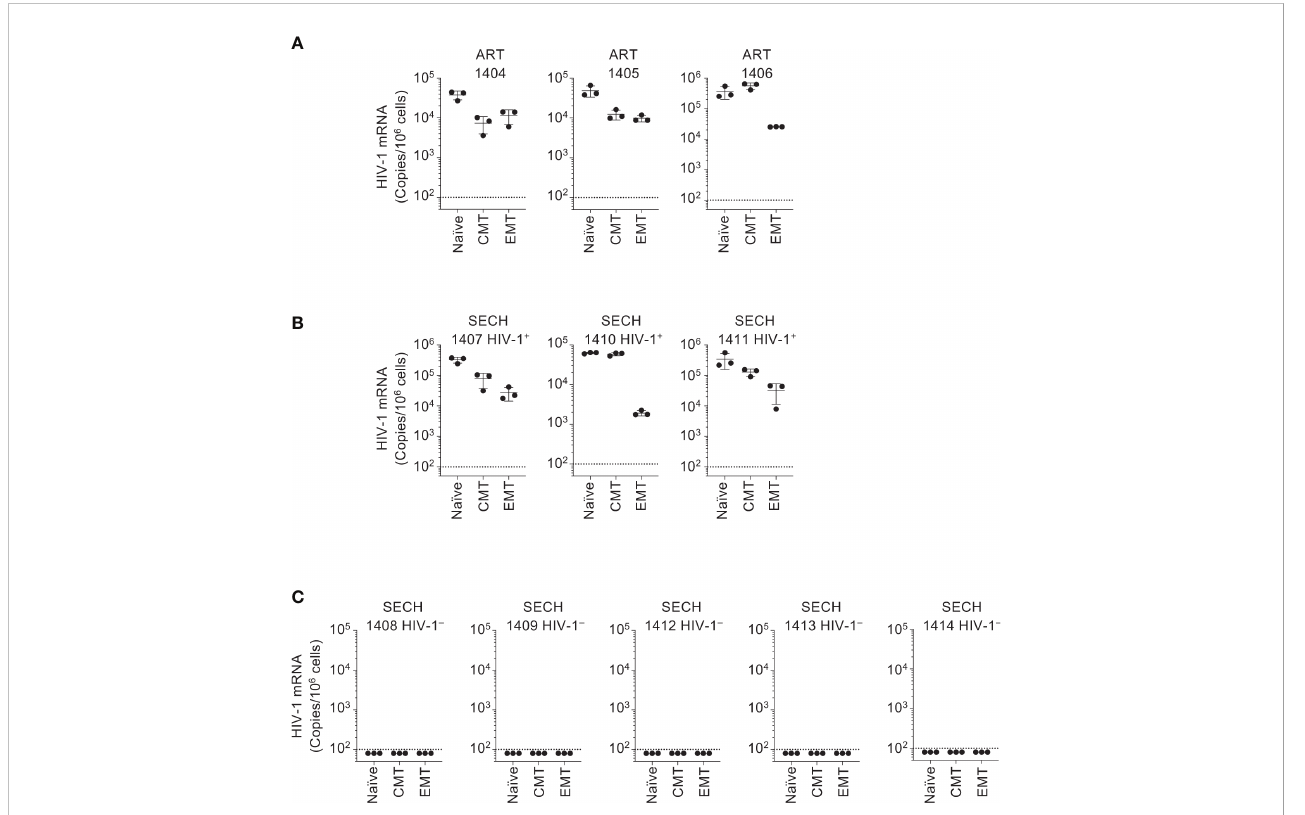
FIGURE 3 Clearance of HIV-1 reservoirs in T cell subsets of Hu-HSC mice by SECH. Human CCR7 + CCD45RO – naïve CD4 + T cells, CCR7 + CCD45RO + CMT and CCR7 – CCD45RO + EMT were sorted from Hu-HSC mice infected with HIV-1 that had been treated by ART (A) , and from the mice with (B) or without (C) HIV-1 rebound after withdrawal of SECH treatment. HIV-1 mRNA levels in the cells were determined by